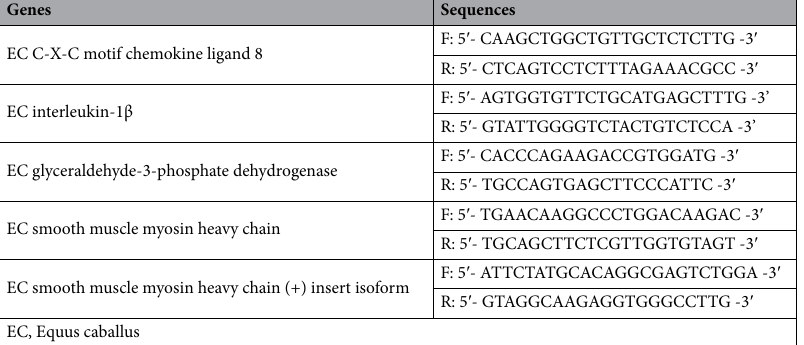
Table 1. Sequences of primer pairs used for quantitative PCR